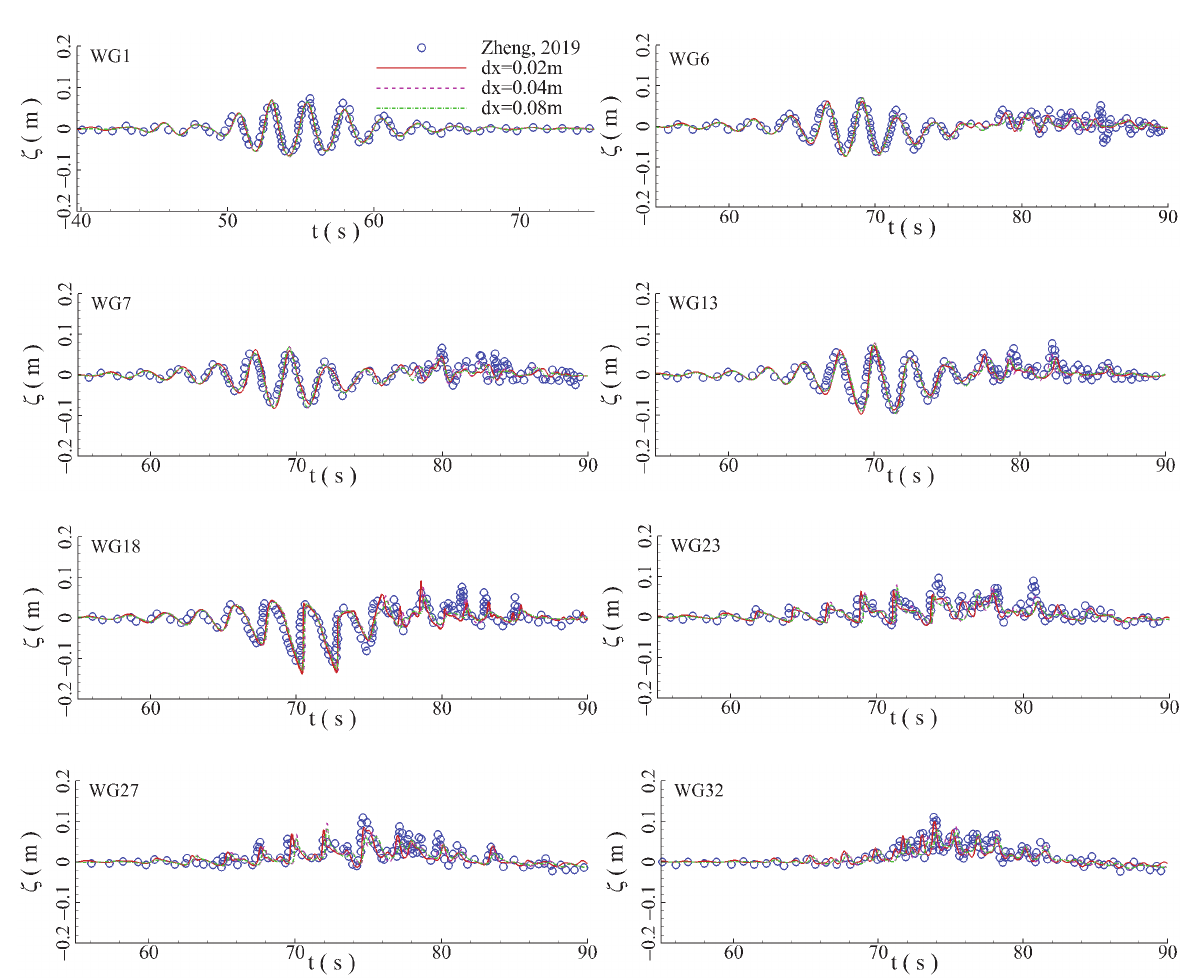
Figure 4. Comparisons of the water elevations obtained numerically with the experimental results.